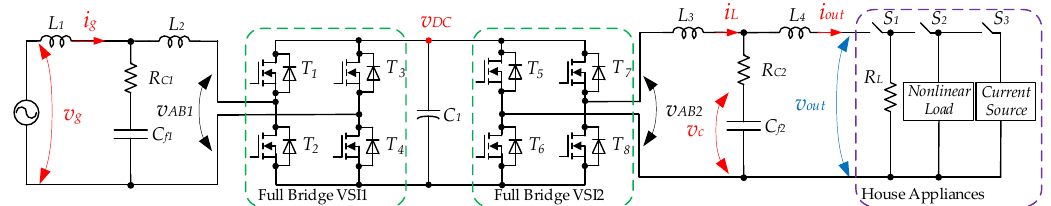
Figure 2. Back-to-back mode circuit diagram of the proposed energy router.